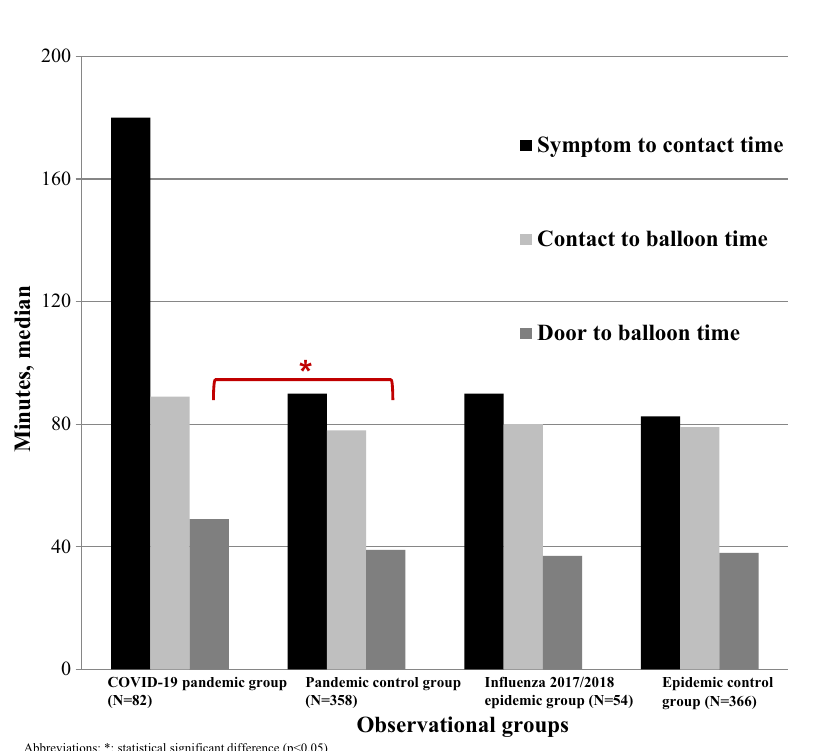
Table 2. Time intervals. S2C symptom-to-contact time, C2B contact-to-balloon time, D2B door-to-balloon time, N2B needle-to-balloon time; *: statistical significant difference. Median [interquartile range].